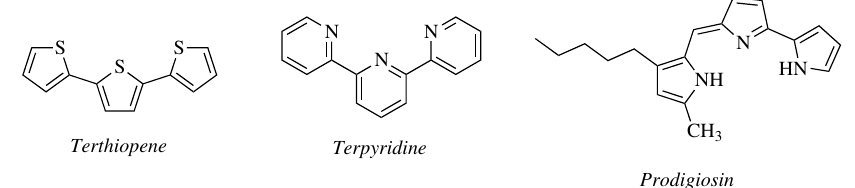
Figure 8. Chemical structure of Terthiopene , Terpyridine , and Prodigiosin